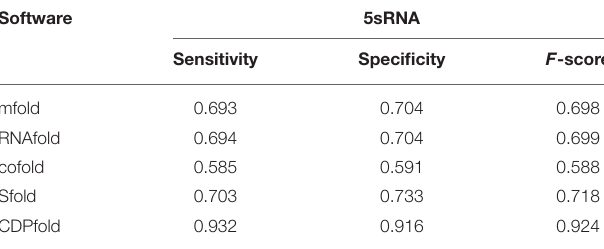
TABLE 2 | Comparison of algorithms in 5sRna.